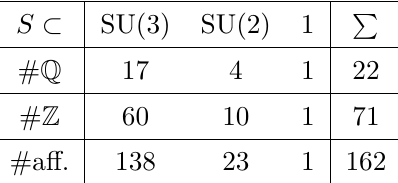
Table 1 . Summary of all orbifold geometries for all Abelian Q -, Z - and affine classes split up into their respective (discrete) holonomy subgroups. Reduced holonomy subgroups lead to en- hanced